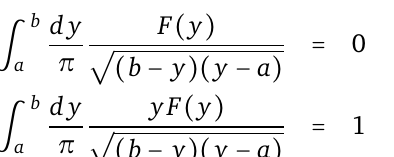
Figure 2: In the α plane, we deform the original integration contour to wrap the eigenvalues that lie on the real axis. The contours C 1 and C 2 cancel each other, and C 3 is vanishing. with the